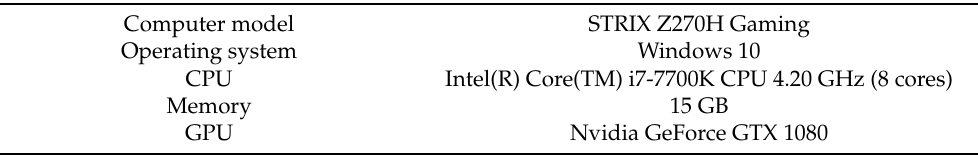
Table 4. Computer